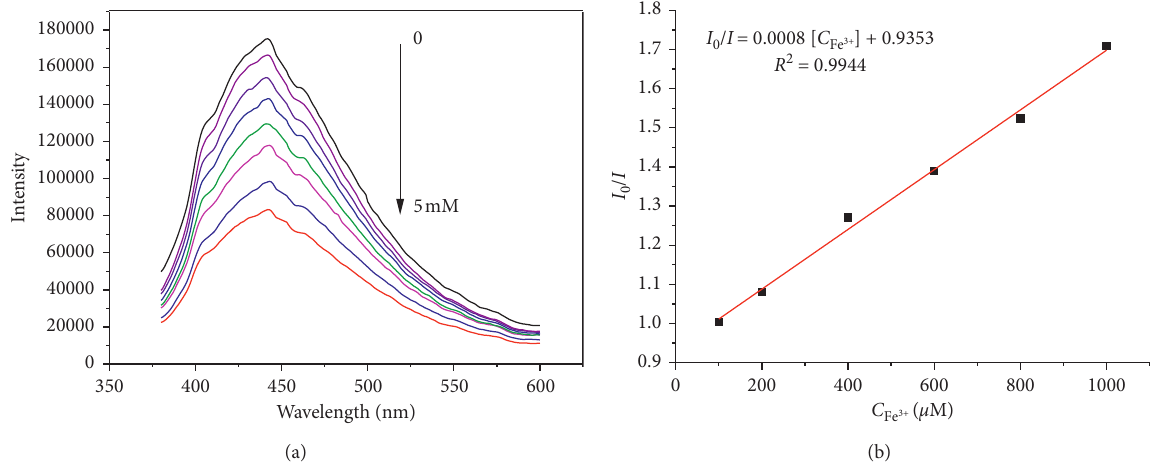
Figure 6: (a) Fluorescence response of the Ag NCs upon addition of different concentrations of Fe 3+ from top to bottom: 0 mM, 0.1mM, 0.2mM, 0.4mM, 0.6mM, 0.8mM, 1mM, and 5mM. (b) The linear calibration ranges of the fluorescence intensity ratio to Fe 3+ concentrations.